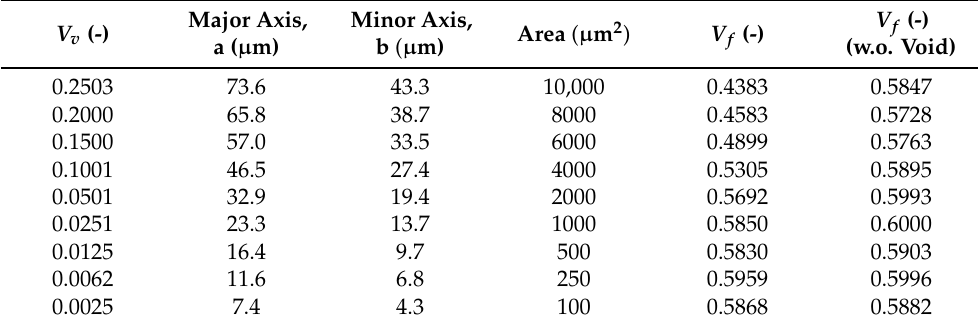
Table 4. V v of the RVEs with an elliptical void angled 45 ◦ and the resulting V f